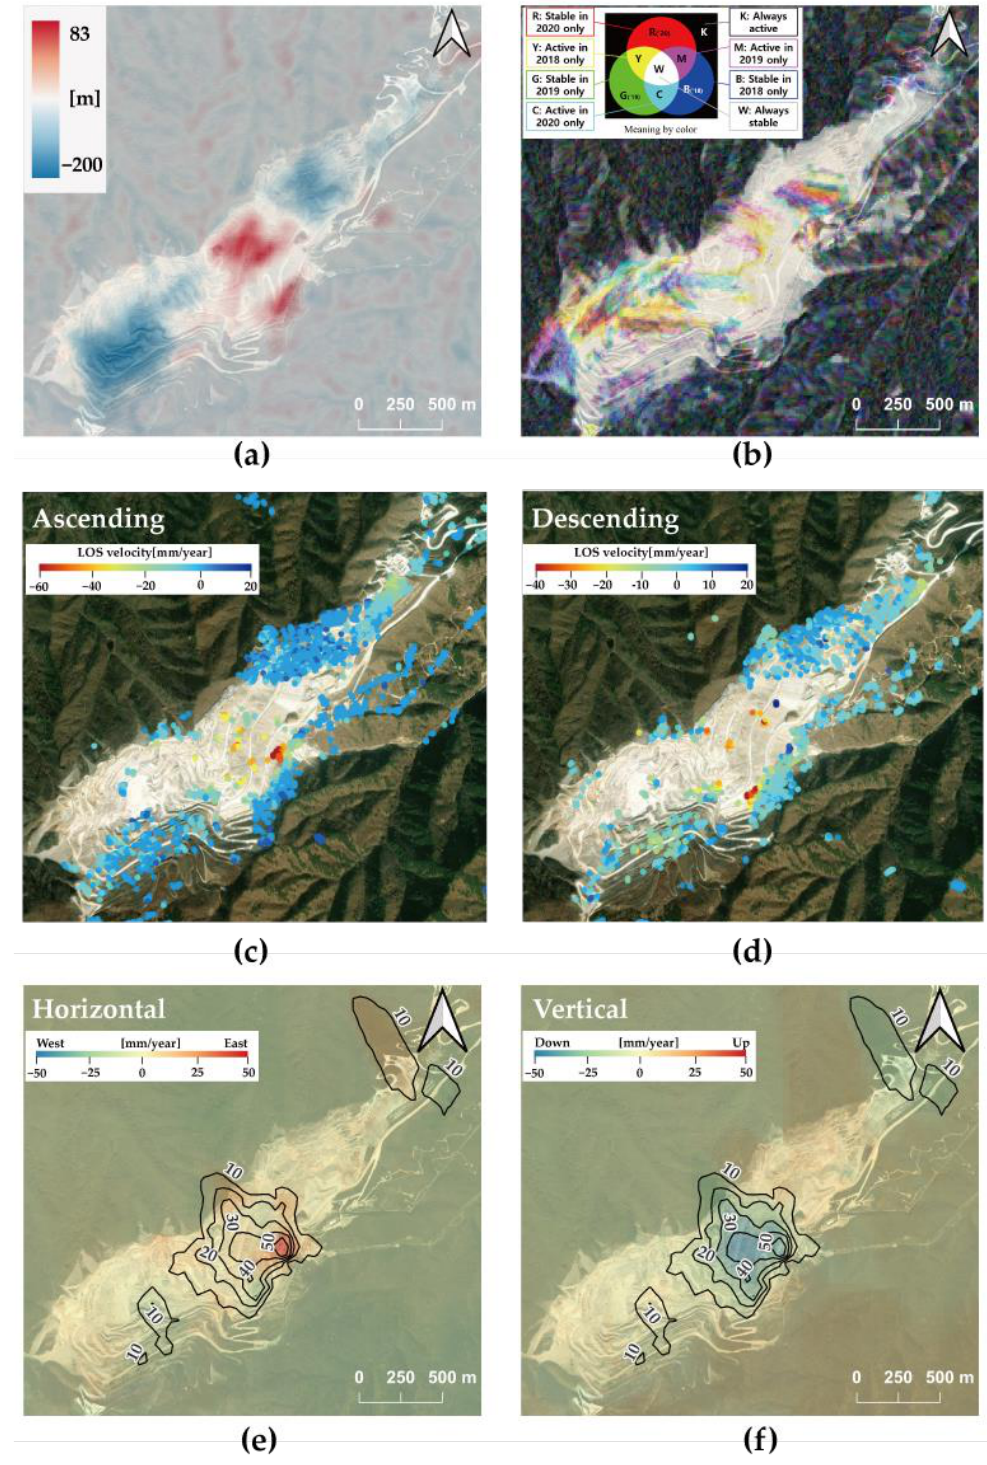
Figure 4. The overall result images from the study area. ( a ) Elevation change from the InSAR DEMs, ( b ) RGB composite of the annually averaged coherence images with R for 2020, G for 2019, and B for 2018, ( c , d ) PSInSAR result images, and ( e , f ) the interpolated horizontal (east) and vertical components of PS.